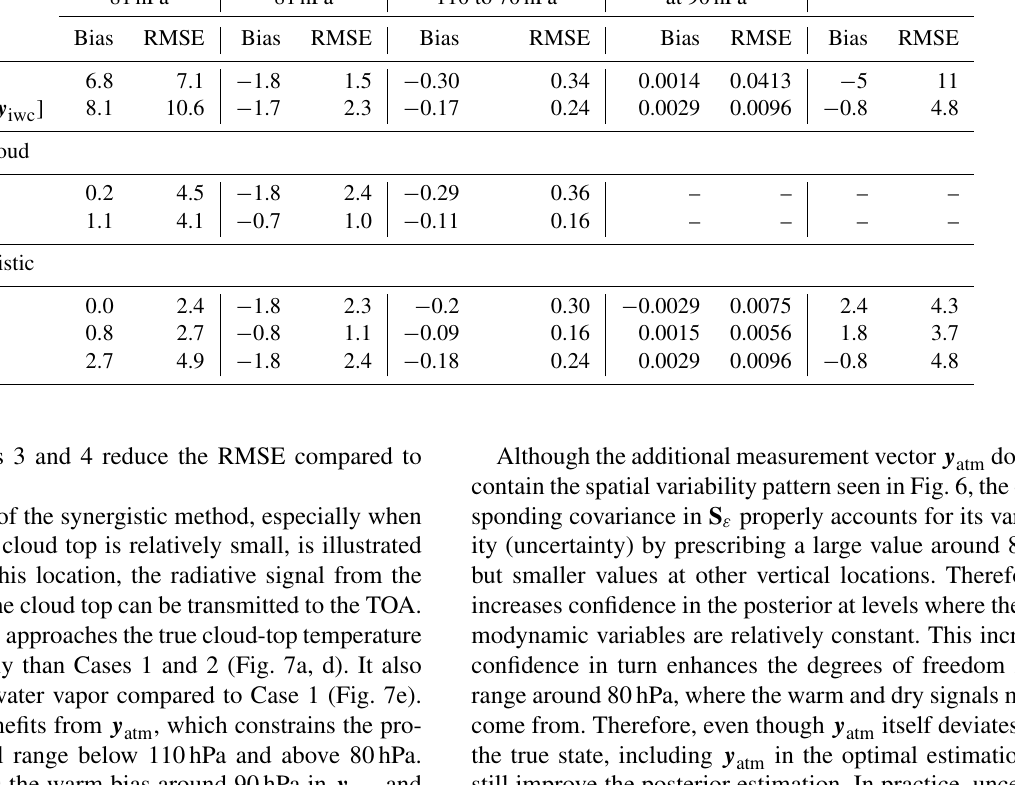
Table 2. Performance assessment of four retrieval strategy cases. The cases are compared with the prior, the observation vector, and Case 5. t (K) at q (ppmv) at CIWV (gm − 2 ) from IWC (gm − 3 ) R e (µm) 81hPa 81hPa 110 to 70hPa at 90hPa Bias RMSE Bias RMSE Bias RMSE Bias RMSE Bias